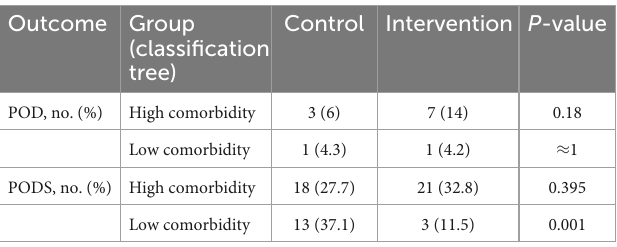
TABLE 4 Developing POD or PODS into comorbidity-level groups by classification tree analysis. Outcome Group (classification